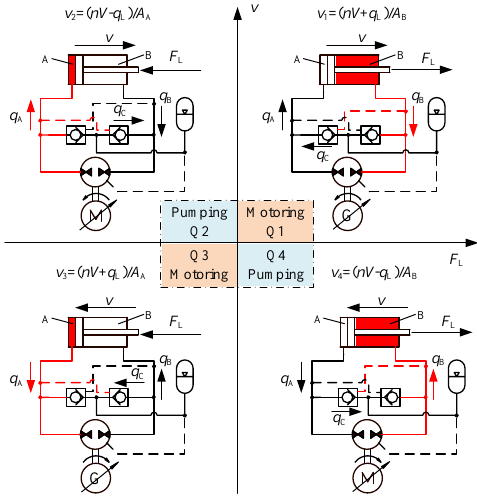
Figure 2. Four-quadrant operation of the SPC.